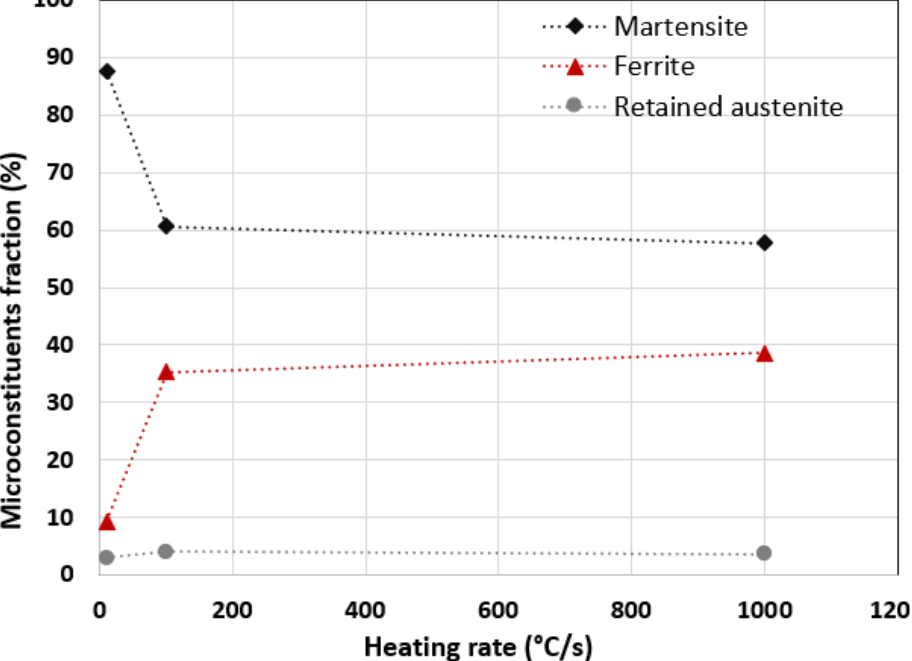
Figure 14. Microstructural evolution at different HRs for peak temperature at 915 °C (data from [57]; steel chemical composition: 0.2% C + Mo + Ti + Nb).